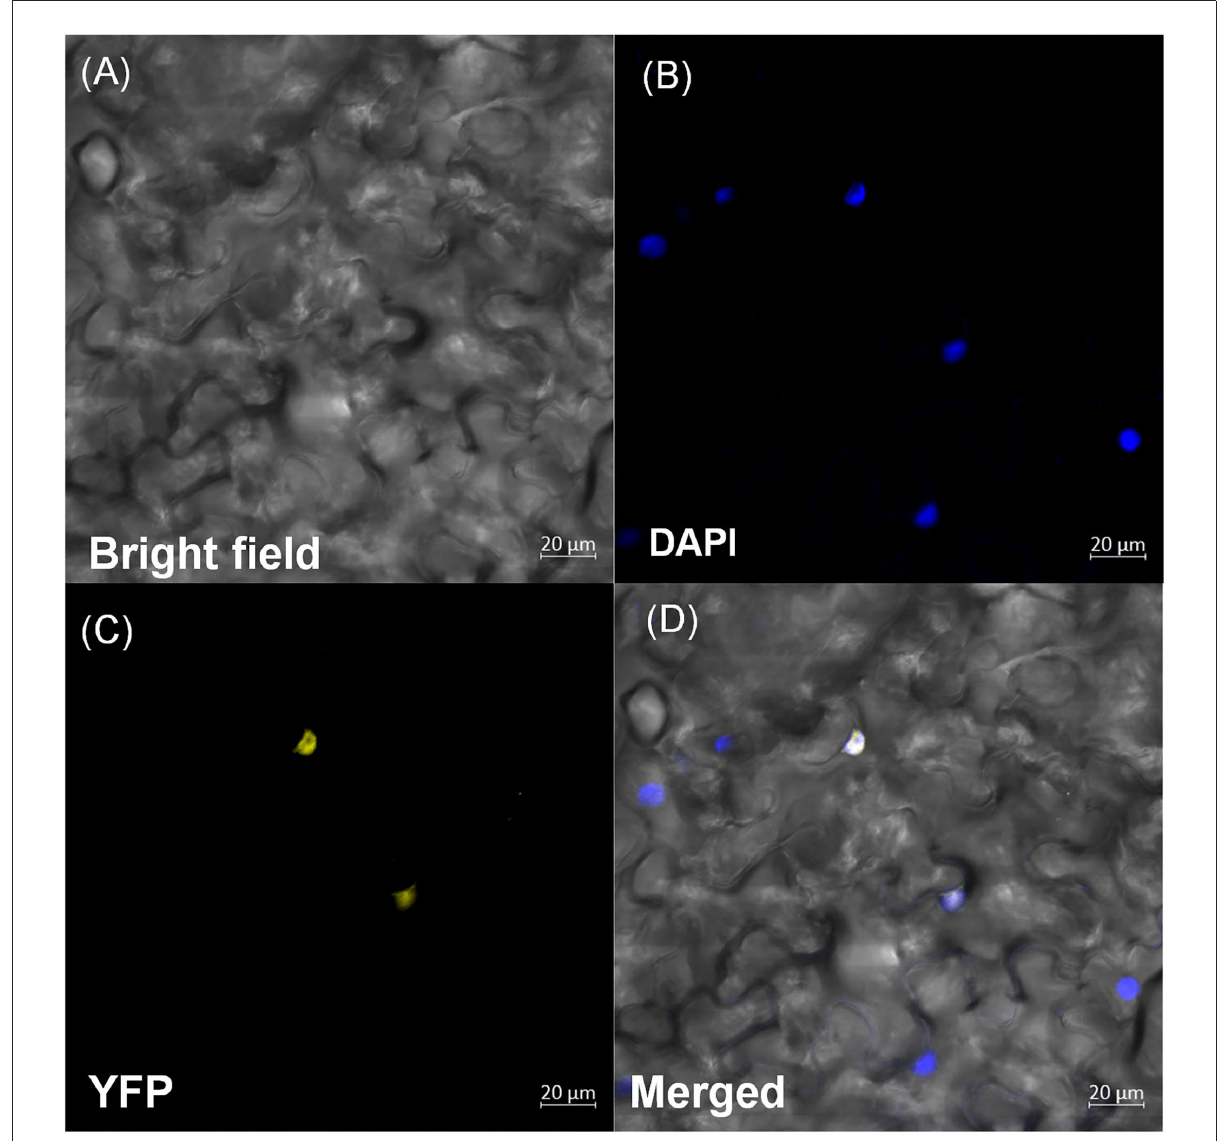
FIGURE3 Subcellular localization of OsDOF27 protein. Six-week-old Nicotiana leaves were syringe-infiltrated at the abaxial surface with Agrobacterium strain harboring pSITEYFP3CA: OsDOF27 constructs. YFP fluorescence and differential interference contrast images and visible/GFP merged images are visualized by confocal microscopy. Scale bars = 20 µ m. Confocal images of nicotiana leaves showing OsDOF27 targeted to the nucleus, with (A) bright field; (B) DAPI; (C) YFP; (D) merged or